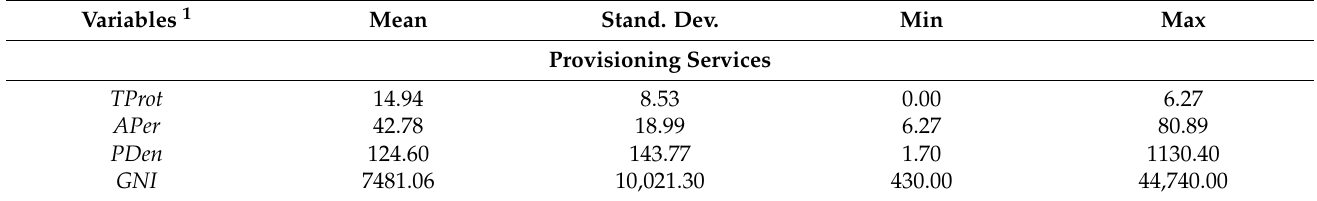
Table 3. Summary statistics for meta-regression variables in ecosystem